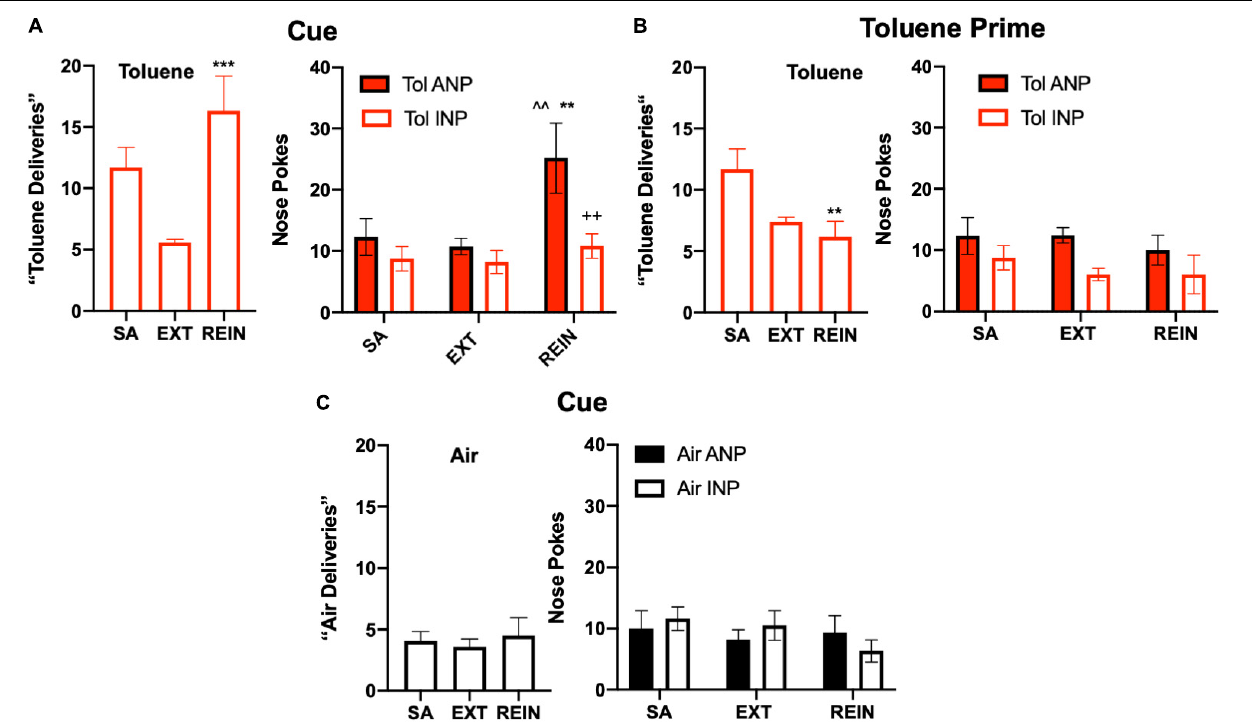
FIGURE 4 | Reinstatement of toluene self-administration behavior. (A) Cue-induced reinstatement of responding in rats extinguished from toluene SA behavior. Left panel shows average vapor deliveries in rats self-administering toluene (SA; last week average), after extinction (EXT) or during re-instatement (REIN); *** p < 0.001 REIN vs. EXT, Dunnett’s post hoc . Right panel shows vapor deliveries, active (ANP) and inactive nose pokes (INP; right panel) vapor deliveries in rats self-administering toluene (SA; last week average), after extinction (EXT) or during re-instatement (REIN); ˆˆ p < 0.01 REIN vs. SA; ** p < 0.01 REIN vs. EXT; ++ p < 0.01 Tol ANP vs. Tol INP during REIN, Sidak’s post hoc . (B) A brief (15 s) exposure to 500 ppm toluene vapor prior to testing failed to reinstate responding in the active hole. One-way ANOVA and post hoc testing revealed a significant difference between SA and REIN groups (** p < 0.01) Data shown are average vapor deliveries (left panel) or active (ANP) and inactive nose pokes (INP, right panel) in rats self-administering toluene (SA; last week average), after extinction (EXT) or during re-instatement (REIN). (C) Cues did not alter responding in Air rats. Data shown are average vapor deliveries (left panel) or active (ANP) and inactive nose pokes (INP; right panel) in rats self-administering Air (SA; last week average), after extinction (EXT) or during re-instatement (REIN). All data are mean ± SEM. Air N = 6, Tol N =